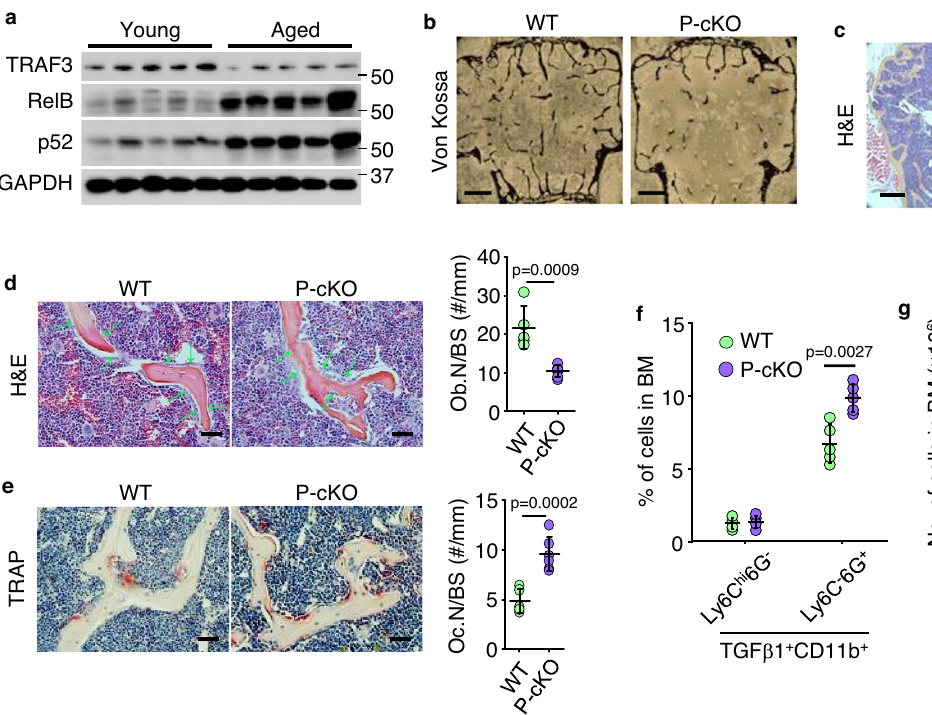
Fig. 4 | Mice with TRAF3 deleted in MPCs have increased numbers of TGF β - expressingneutrophilsinBM.a WBsofTRAF3,RelB,p52,andGAPDHexpression in total protein lysate extracted from leg bones (with BM) from 3- (young) and 18- mon-old(aged)C57mice. b von-Kossa-stainedplasticsectionsofL1vertebraefrom 12-mon-oldPrx1 Cre ;TRAF3 fl / fl (P-cKO)miceandWTlittermates.Bar=400 μ m. c H&E- stained paraf fi n sections of L2vertebrae from12-mon-oldWT and P-cKO mice,and d OB surfaces (Ob.S/B.S). Bar=400 μ m in ( c ) and 50 μ m in ( d ). Mean±SD ( n =8